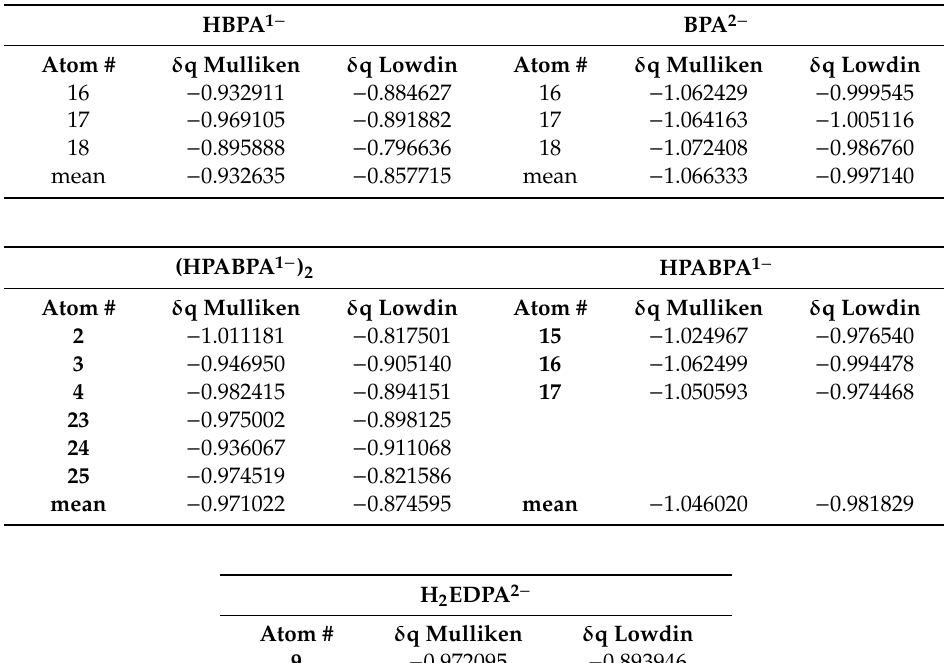
Table 2. B3LYP / PCM calculated partial charges on the oxygen